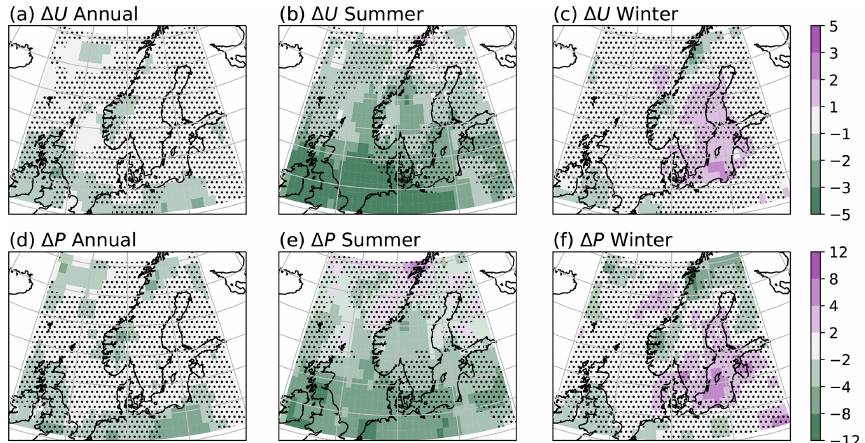
Figure 8. Median of the ensemble relative change (%) in 100ma.g.l. wind speed among the CMIP6 models (a) – (c) and wind power density (d) – (f) between the future (2031–2050) and the past (1995–2014). Medians are computed for the annual means ( (a) and (d) ), JJA means (summer, (b) and (e) ), and DJF means (winter, (c) and (f) ). The dotted areas represent areas where less than 75% (or 12 of 16) of models agree on the sign of the change. See the text for the procedure used to compute the data displayed.